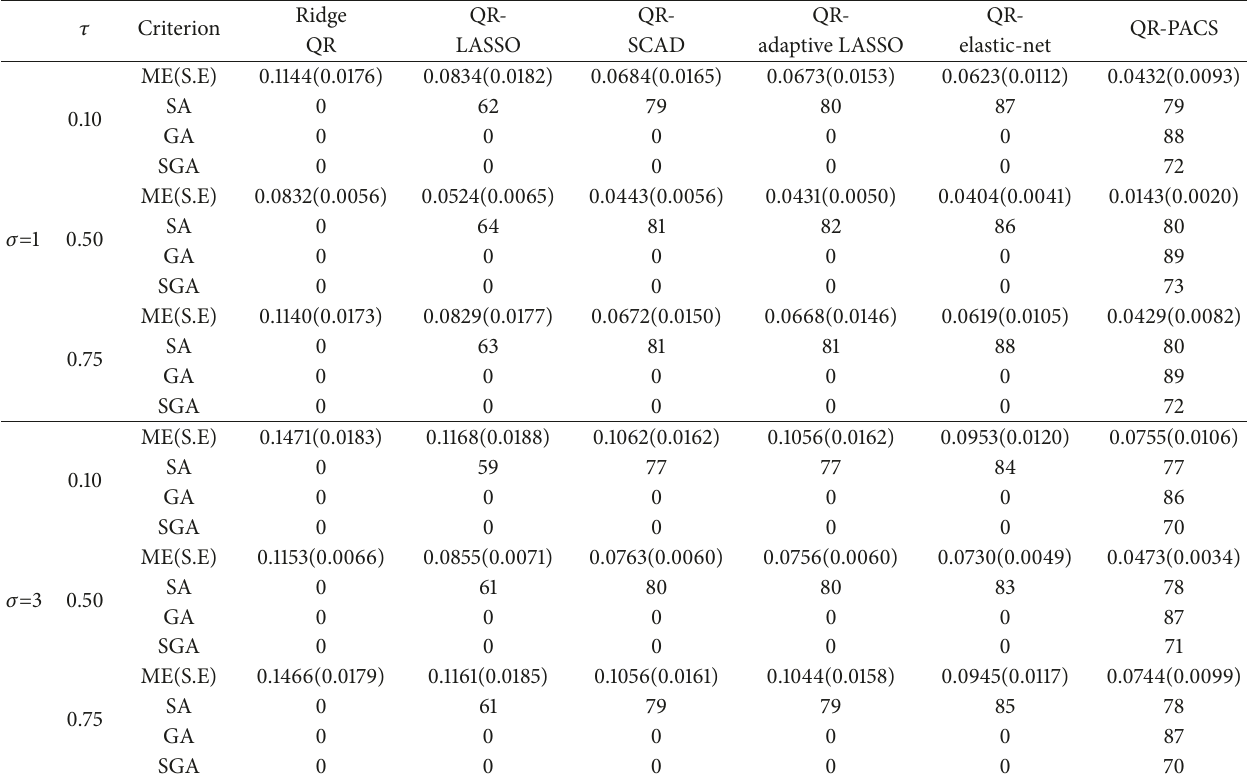
Table 1: ME, SA, GA, and SGA results of Example 1 for